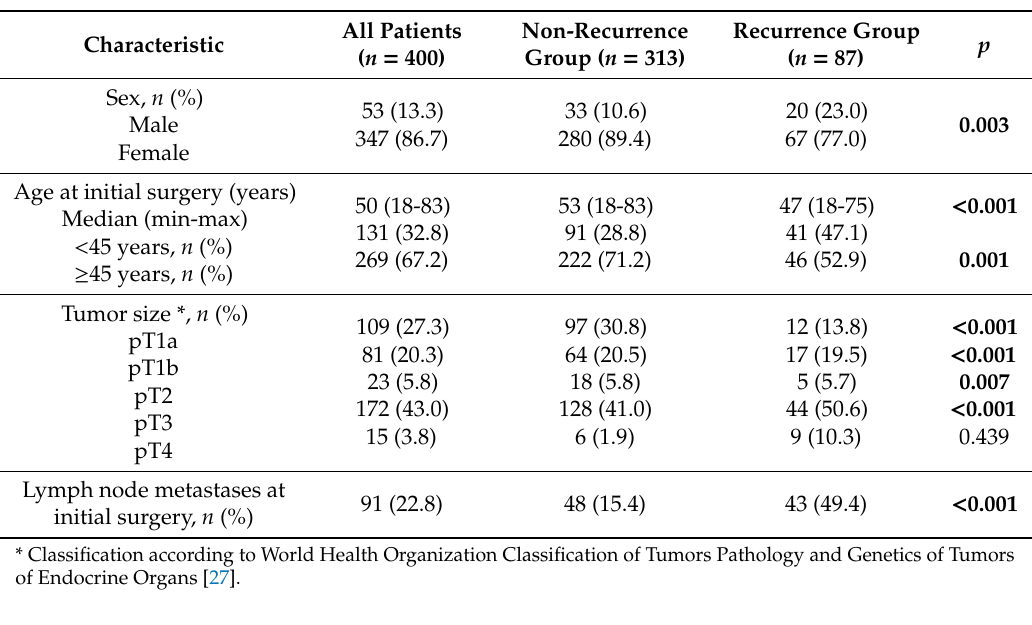
Table 1. Demographic and clinicopathological characteristics of the study population.